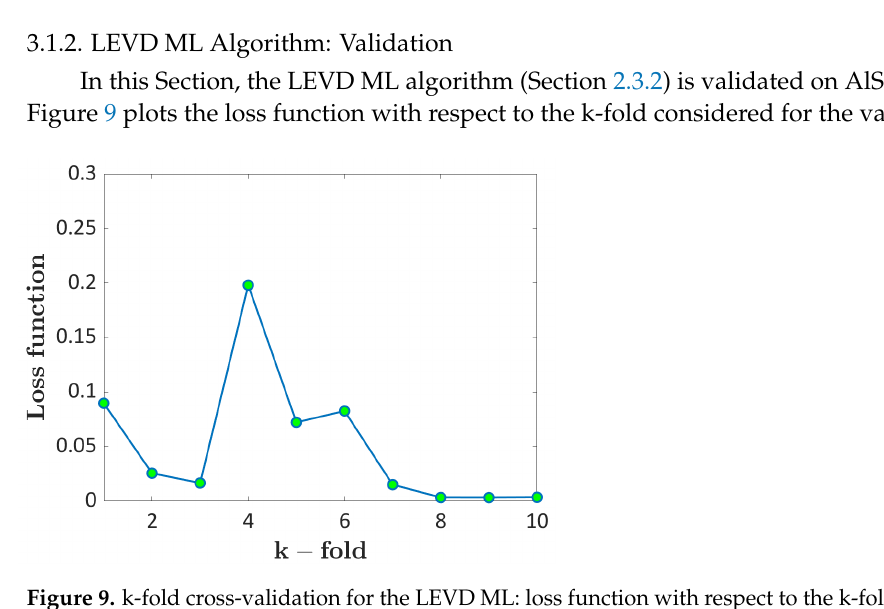
Figure 8. Validation of the investigated Probability ML algorithm: ( a ) Gumbel plot for the validation dataset for k = 4; ( b ) P-P plot for k = 4 by considering the training and the validation data.